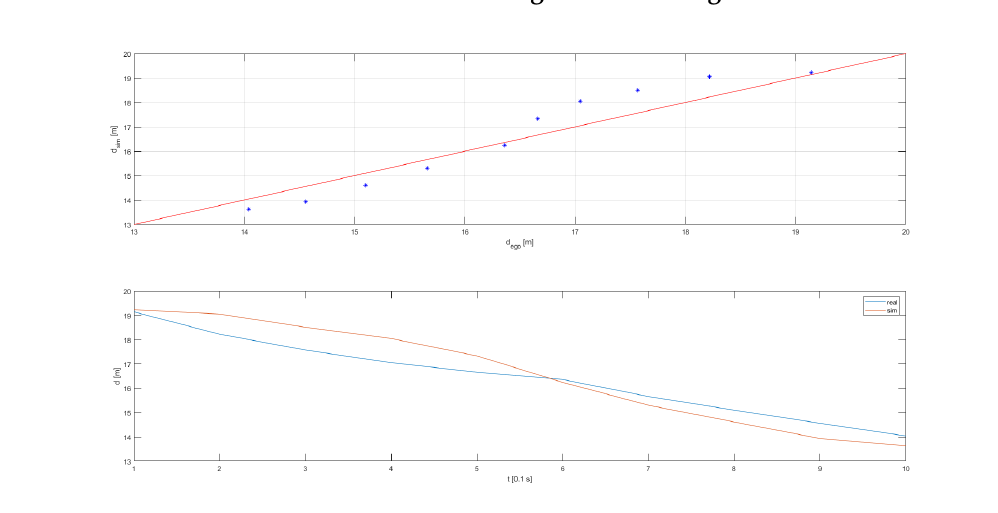
Figure A6. Validation of the real and estimated distance between ego target vehicle in scenario